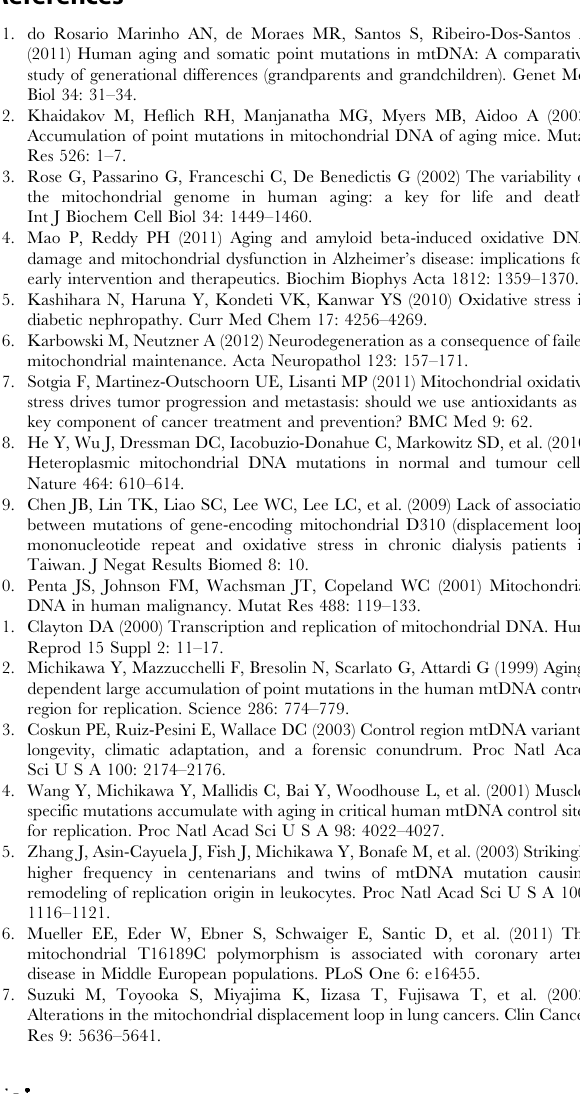
Table S2 Control (n= 704)-D-loop trimmed sequences in FSATA format. Table S3 77 SNP genotype raw data for cases and controls. Table S4 P values of 77 individual SNPs for cases and